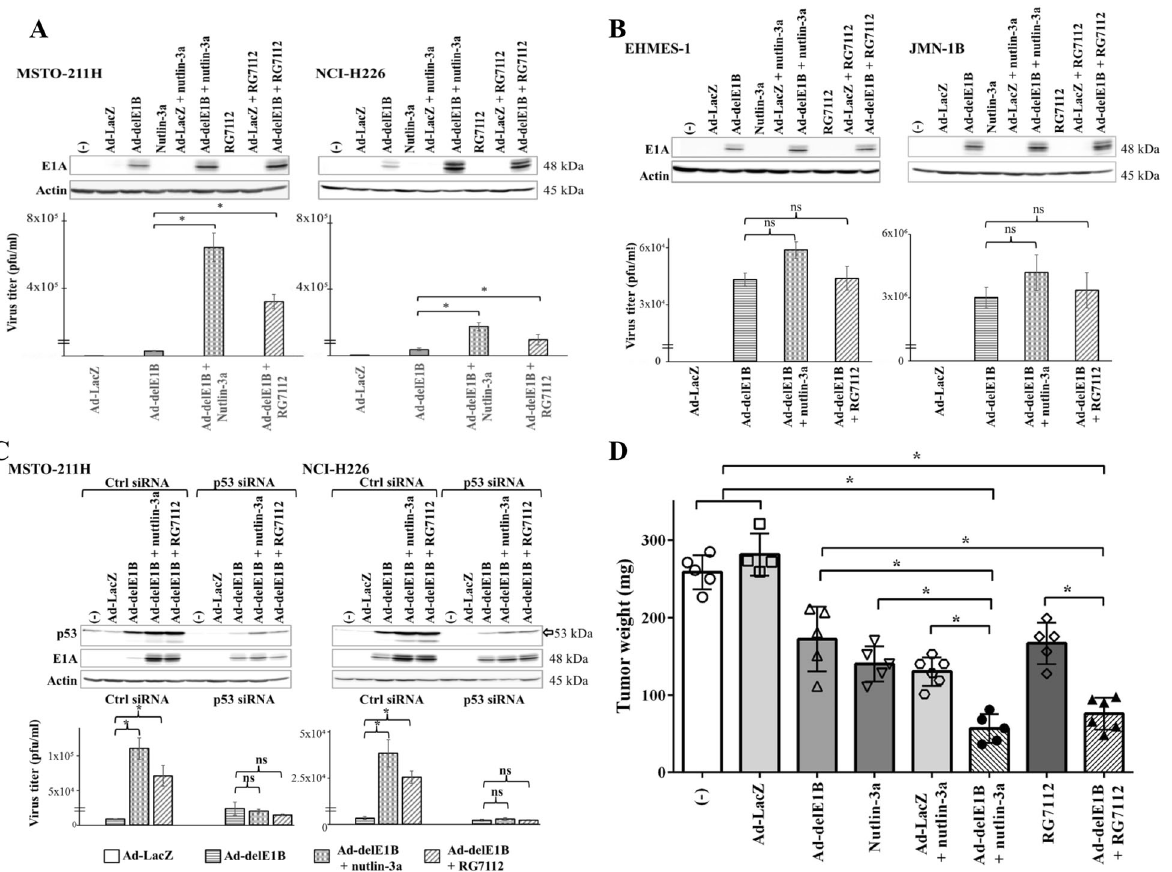
Fig. 5 MDM2 inhibitors augmented production of Ad-delE1B progenies through p53 expression and combination suppressed tumor growth in vivo. Wild-type ( A , C ) and mutated p53 cells ( B ) were infected with Ad-delE1B or Ad-LacZ (3 × 10 3 vp/cell) for 2 days, and treated with nutlin-3a (15 µM) or RG7112 (10 µM) for further 16 h in MSTO-211H or 36 h in NCI-H226. Expression of p53, E1A, and actin as a control was examined with Western blot analysis. Quantitation of virus progenies was examined with the TCID 50 method. Averages and SE bars are shown ( n = 3). ns not signi fi cant, * p < 0.01. C Expression of p53 was knocked down with p53 siRNA and control siRNA was used as a control. Cells transfected with siRNA were infected with Ad-delE1B for 2 days, and then treated with nutlin-3a (15µM) or RG7112 (10 µM) for further 16 h in MSTO-211H or 36 h in NCI-H226. D Ad-delE1B (1 × 10 10 vp/mouse) and MDM2 inhibitors (1 mg) produced combinatory anti-tumor effects in an animal experiment. Ad-LacZ was used as a control. The data indicated individual tumor weights and an interquartile range of weights of tumors. * p <